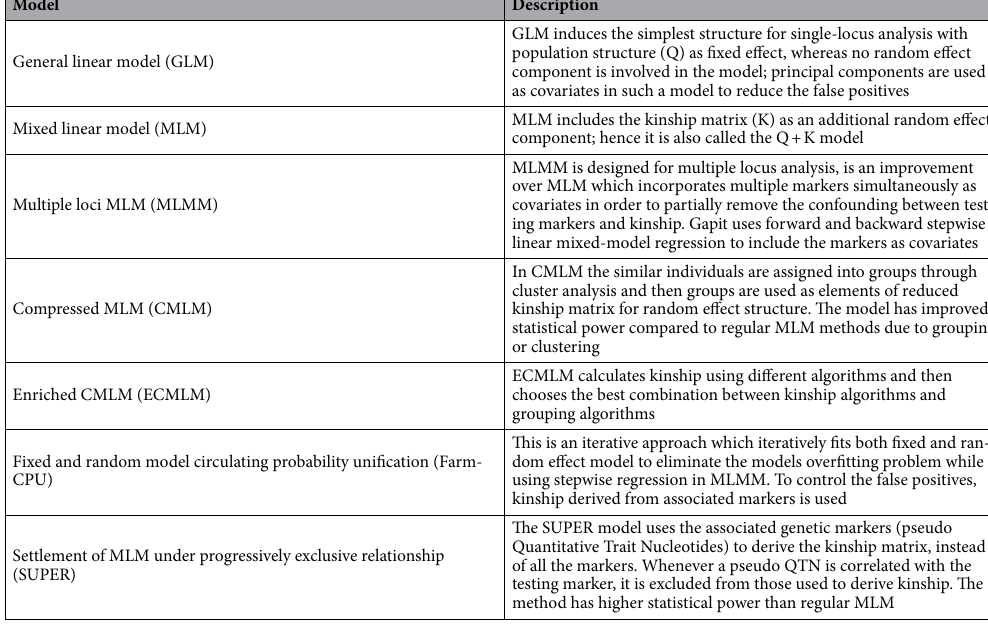
Table 1. Description of the association mapping